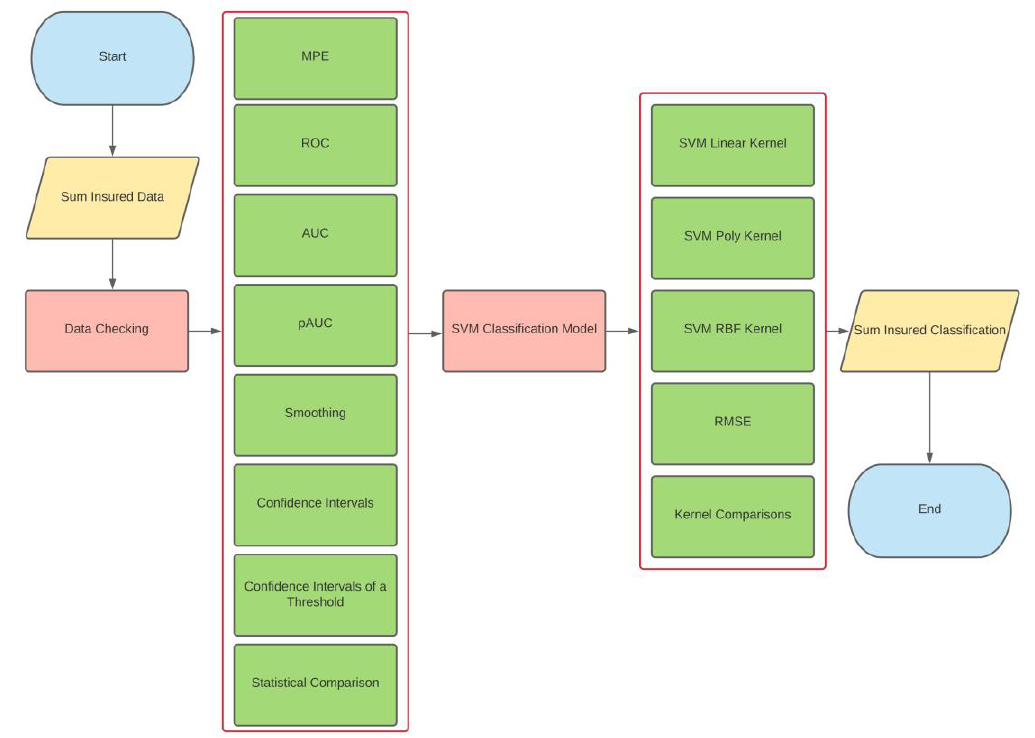
Figure 1. Research steps in classification with SVM